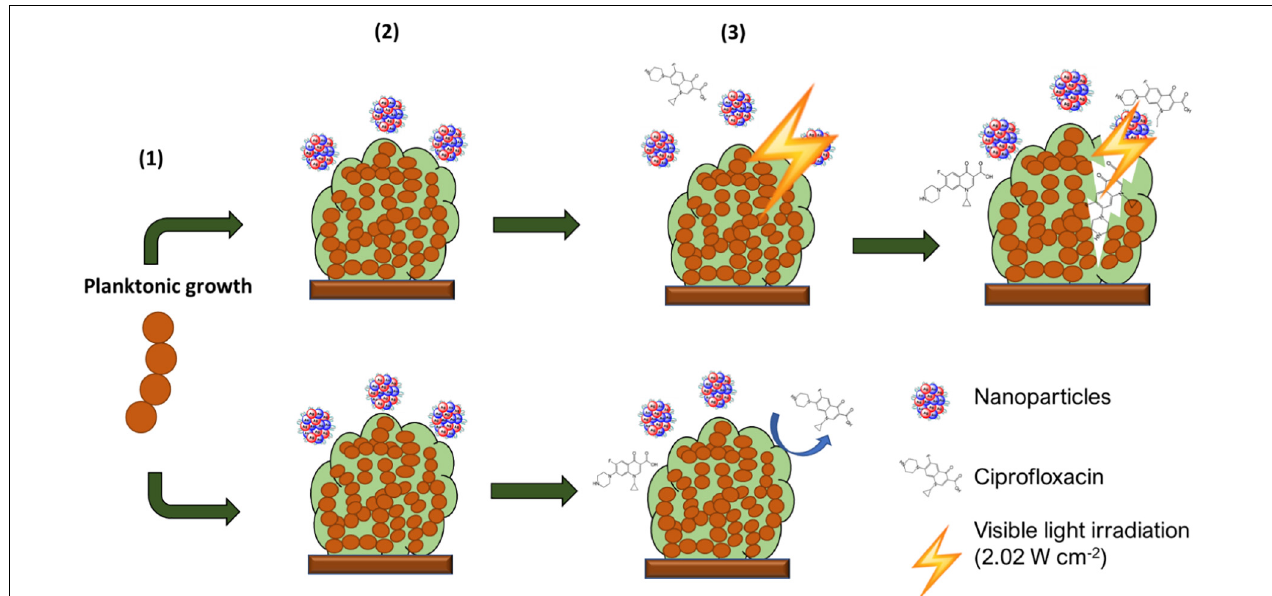
FIGURE 1 | Schematic description of experimental setup. From the initial planktonic bacterial growth, biofilms were allowed to form. These were then washed to remove non-adherent bacteria and exposed to AuAgNP When indicated, these were irradiated and further cultured in presence of AuAgNPs and Ciprofloxacin (10 µ